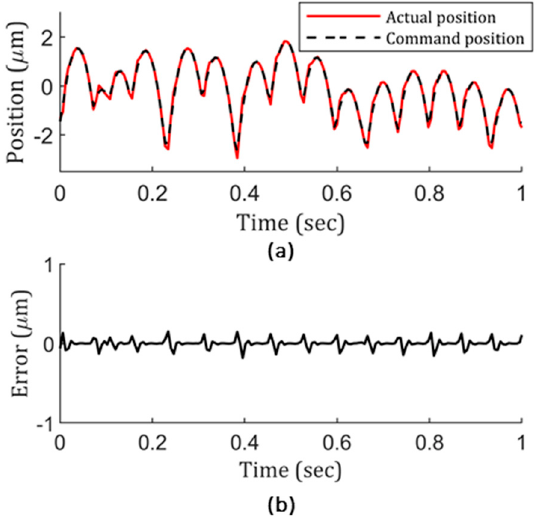
Figure 5. ( a ) Actual vs. command position in the z-axis of STS with a 0.004 s inverse time feed and a 0.25° constant-angle cutting condition and corresponding ( b ) position following error.